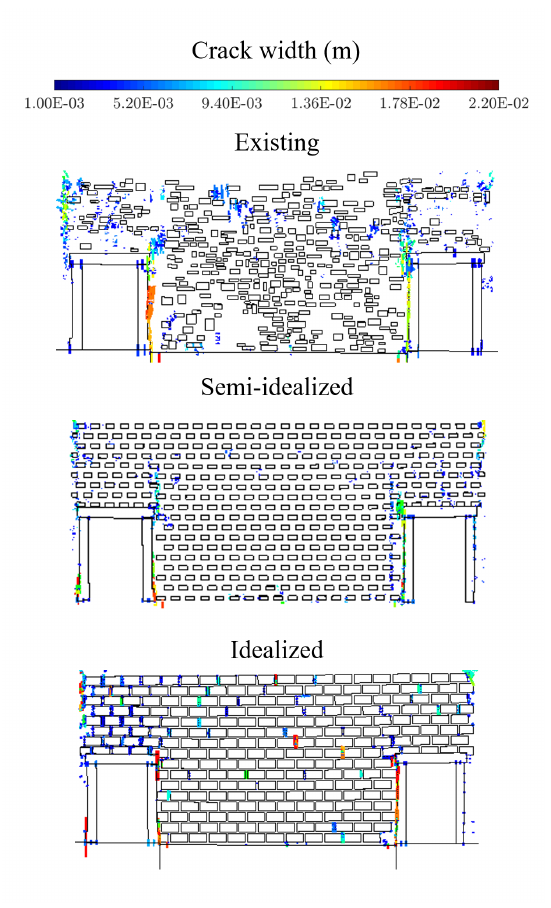
Figure 9. Results of simulation for existing, perturbed, and